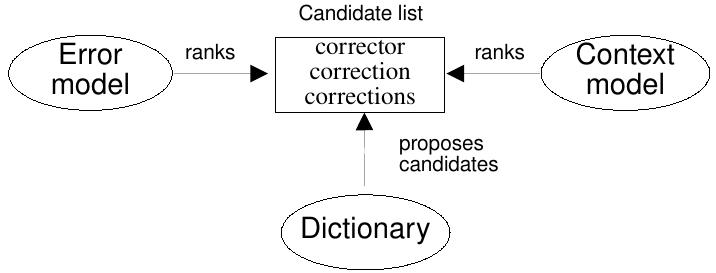
Figure 4. Components of an automatic spelling correction